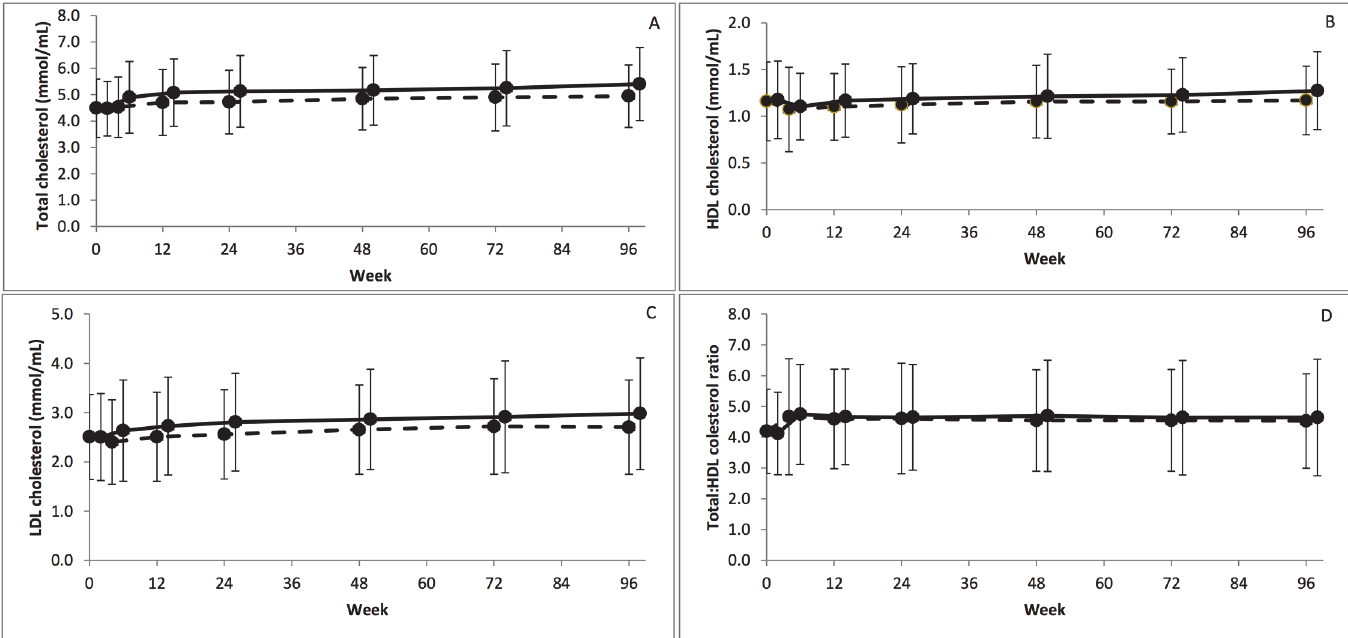
Fig 4. Absolute mean cholesterol fractions and ratio over 96 weeks by randomised arm. (A) total cholesterol, (B) high density lipoprotein (HDL) cholesterol, (C) low density lipoprotein (LDL) cholesterol, (D) Total:HDL cholesterol ratio. RAL = lopinavir/ritonavir+raltegravir Control = lopinavir/ritonavir+2/3 nucleoside/nucleotide reverse transcriptase inhibitors. (Control - - - RAL — , bars indicate standard deviation).